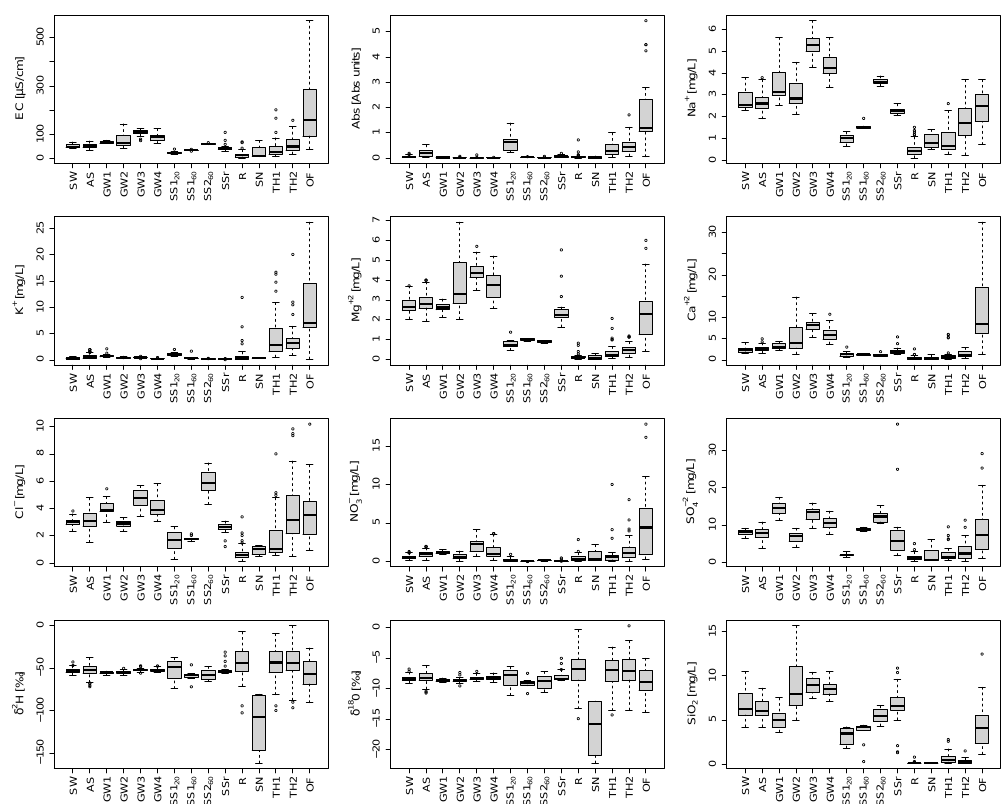
Figure 5. Boxplots of tracers measured for stream water sampled fortnightly (SW, n = 47) and using automatic samplers (AS, n = 179), groundwater (GW1, n = 24; GW2, n = 49; GW3, n = 49; GW4, n = 47), soil water (SS1 20 , n = 22; SS1 60 , n = 10; SS2 60 , n = 9), soil water from the riparian zone (SSr, n = 21), rainfall (R, n = 44), snow (SN, n = 4), throughfall (TH1, n = 35; TH2, n = 38) and overland flow (OF, n = 21). Outliers were